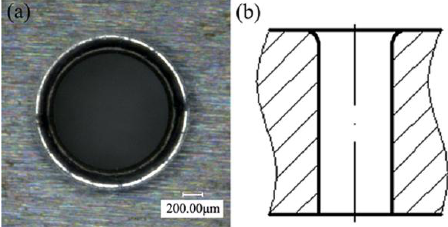
Figure 2. ( a ) Top view of the micro-die; ( b ) cross-sectional diagram of the micro-die.